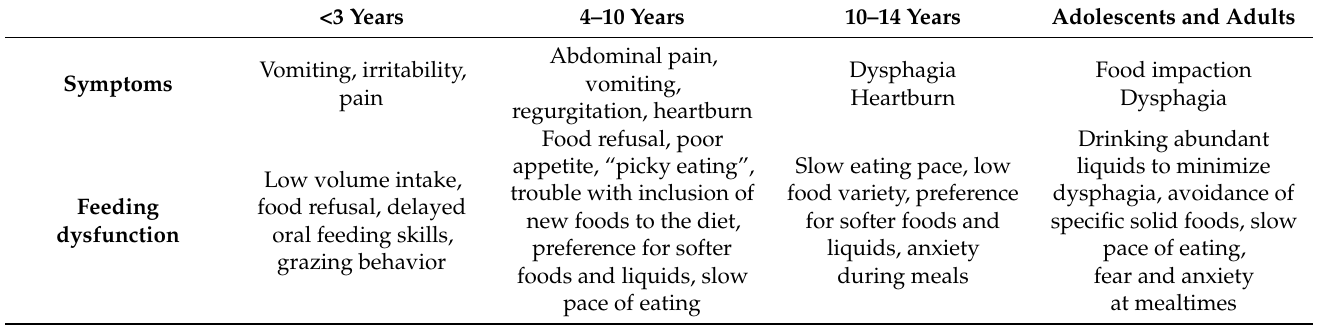
Table 3. Clinical presentation of EoE with subsequent features of maladaptive feeding by age